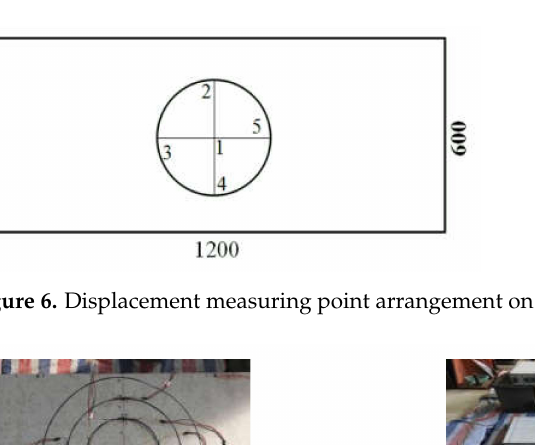
Figure 5. Layout drawing of strain measuring point of specimen.